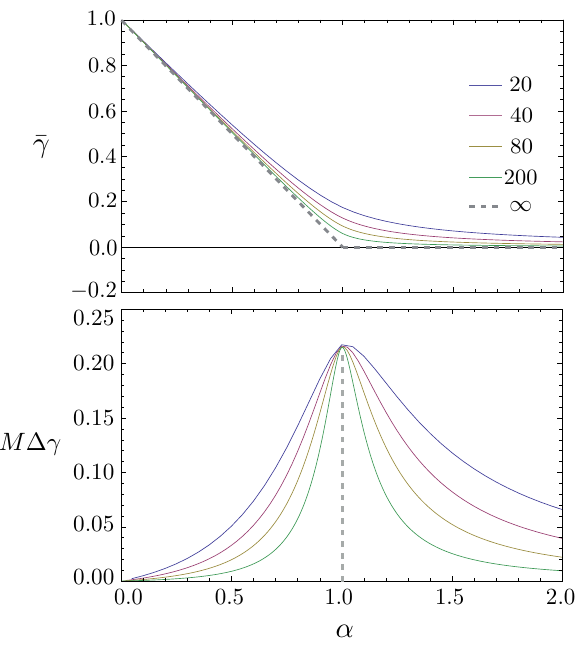
Figure 7: Top: Average photon emission (¯ γ ) vs. imbalance α , for various system sizes ( M ). The inferred curve in the thermodynamic limit ( M → ∞ ) is shown as the grey dashed line. Bottom: Variance of γ multiplied by system size M , as a function of α . The plot is non-monotonic with a peak at α = 1. In the thermodynamic limit, this plot becomes a delta function. understood from the spread of the distribution as shown for three cases in Fig. 6. When α (cid:54) = 1, the standard deviation scales as 1 / M and the variance scales as 1 / M 2 . As a result, { M × ( ∆ γ ) α } vanishes as M → ∞ . In contrast, at the critical point given by α = 1, the variance scales as 1 / M and { M × ( ∆ γ ) α } approaches a constant